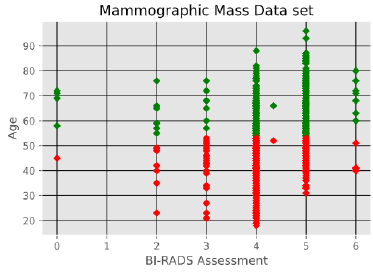
Figure 6. Illustration of the first two attributes of the Mammographic Mass data set. 5.